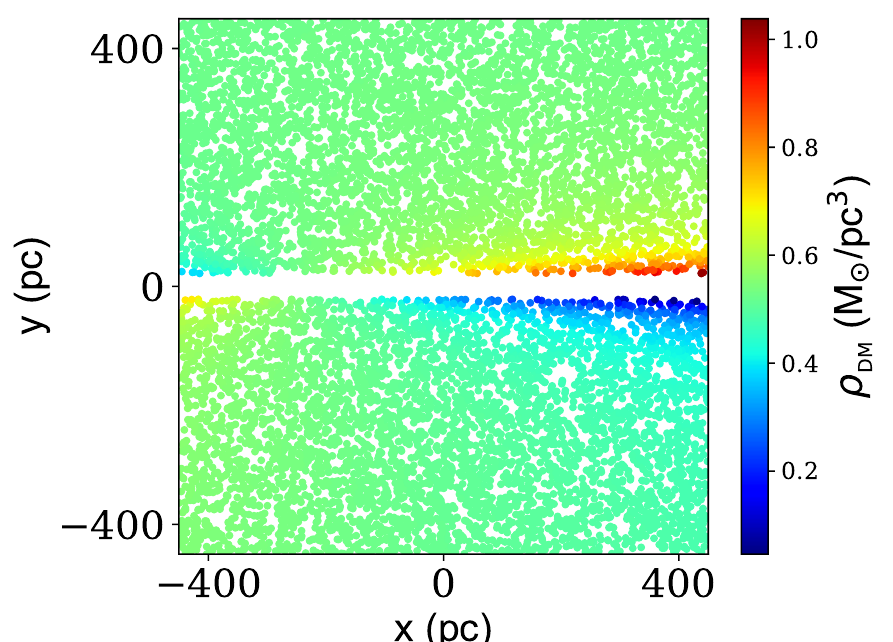
Figure 2. The mass density distribution of DM at the center of the Fornax dSph galaxy on the x–y plane of the comoving coordinate system. We have randomly picked 10,000 points in this x − y region and have calculated the DM mass density at those points. The plot indicates a core distribution of DM mass at the center of the Fornax dSph, with mean DM mass density of 0.5 ( M (cid:12) /pc 3 ) . The mass density fluctuations can be readily seen. There are ingenuine correlations between the points closer than 100 (pc), i.e., similar colors grouped together, which are induced by the kernel density estimator.